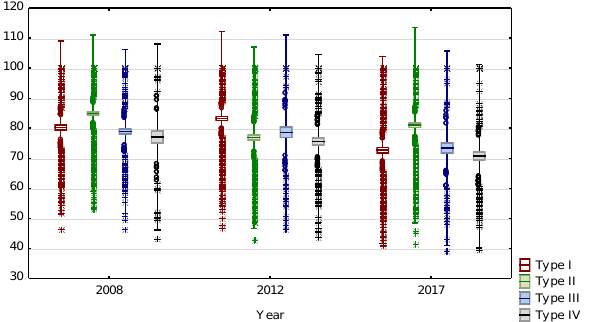
Figure 1. Box plot for BCC values in the studied years and in individual types of farms.